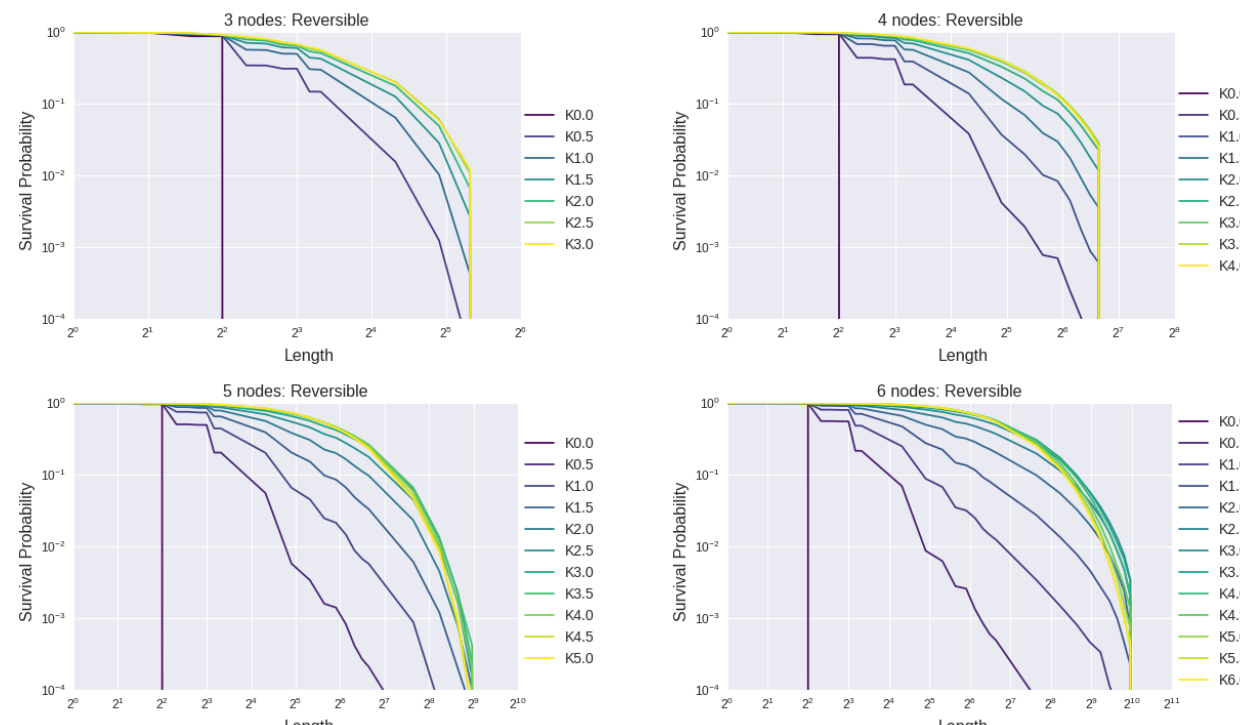
Figure A2. Survival probability for different connectivity values of RevBNs with 3, 4, 5, and 6 nodes. The survival probability was computed from 20,000 realizations.